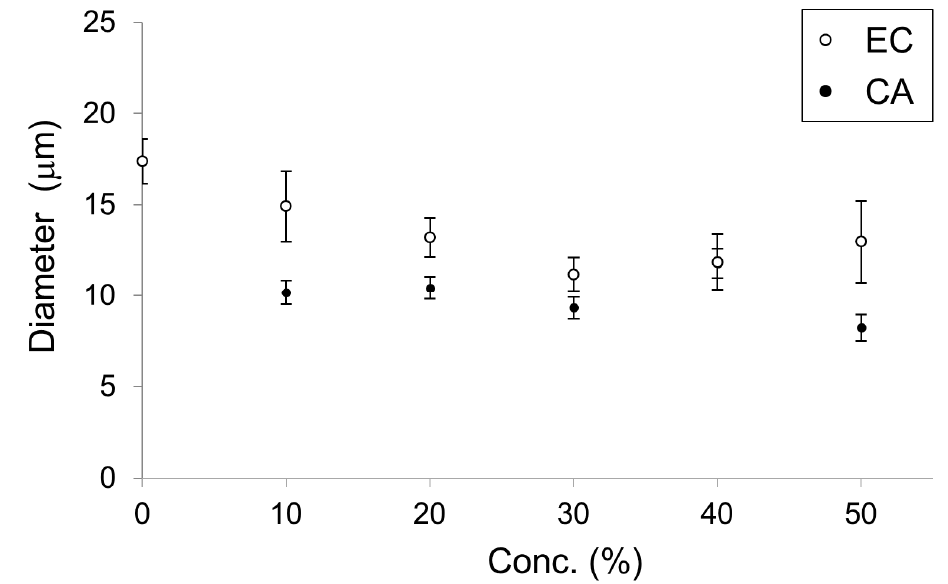
Figure 6. Diameter of lipid vesicles with membranes containing ethyl caproate (EC, white dots) and caproic acid (CA, black dots) at concentrations from 0 to 50%. These data were reconstructed from our previous study [5].